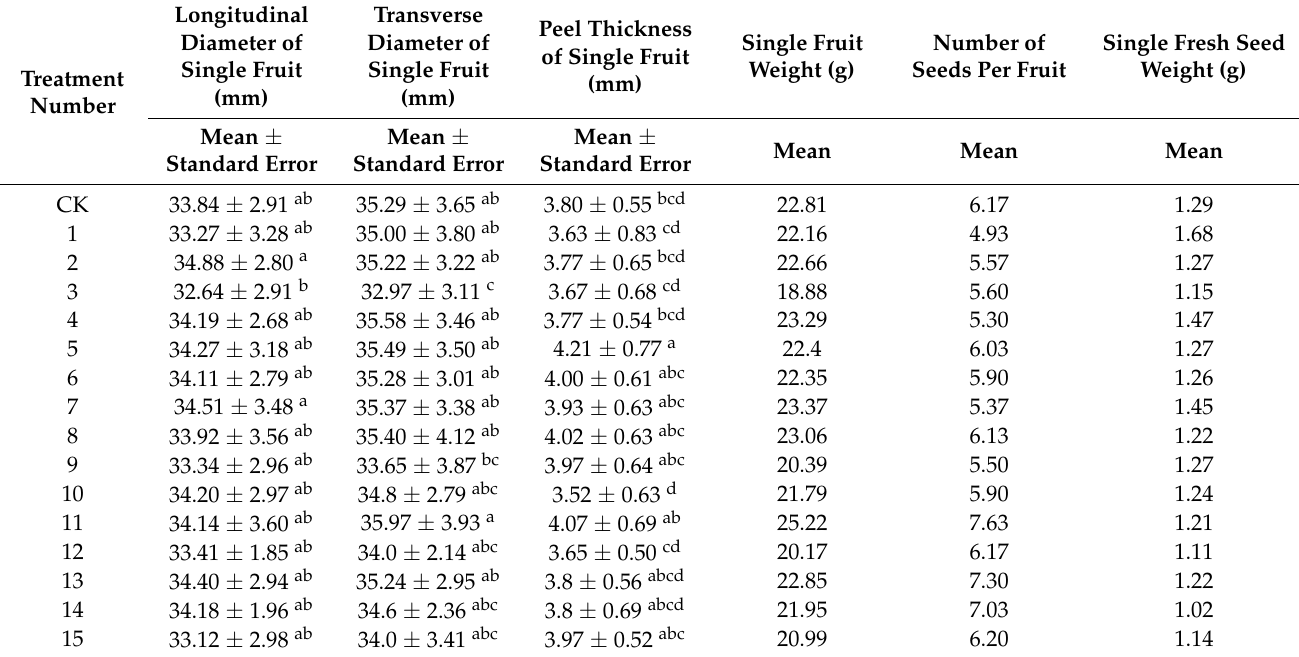
Table 2. Multiple comparison of the effects of trace elements on Camellia oleifera fruit